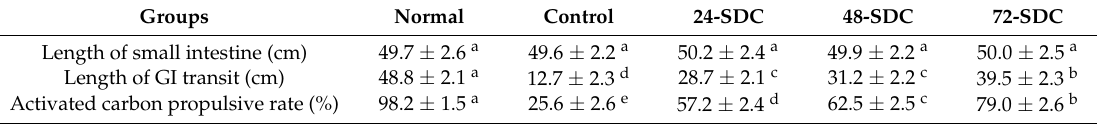
Table 6. Effects of Shuidouchi on gastrointestinal (GI) transit in 30 min in constipated mice. Groups Normal Control